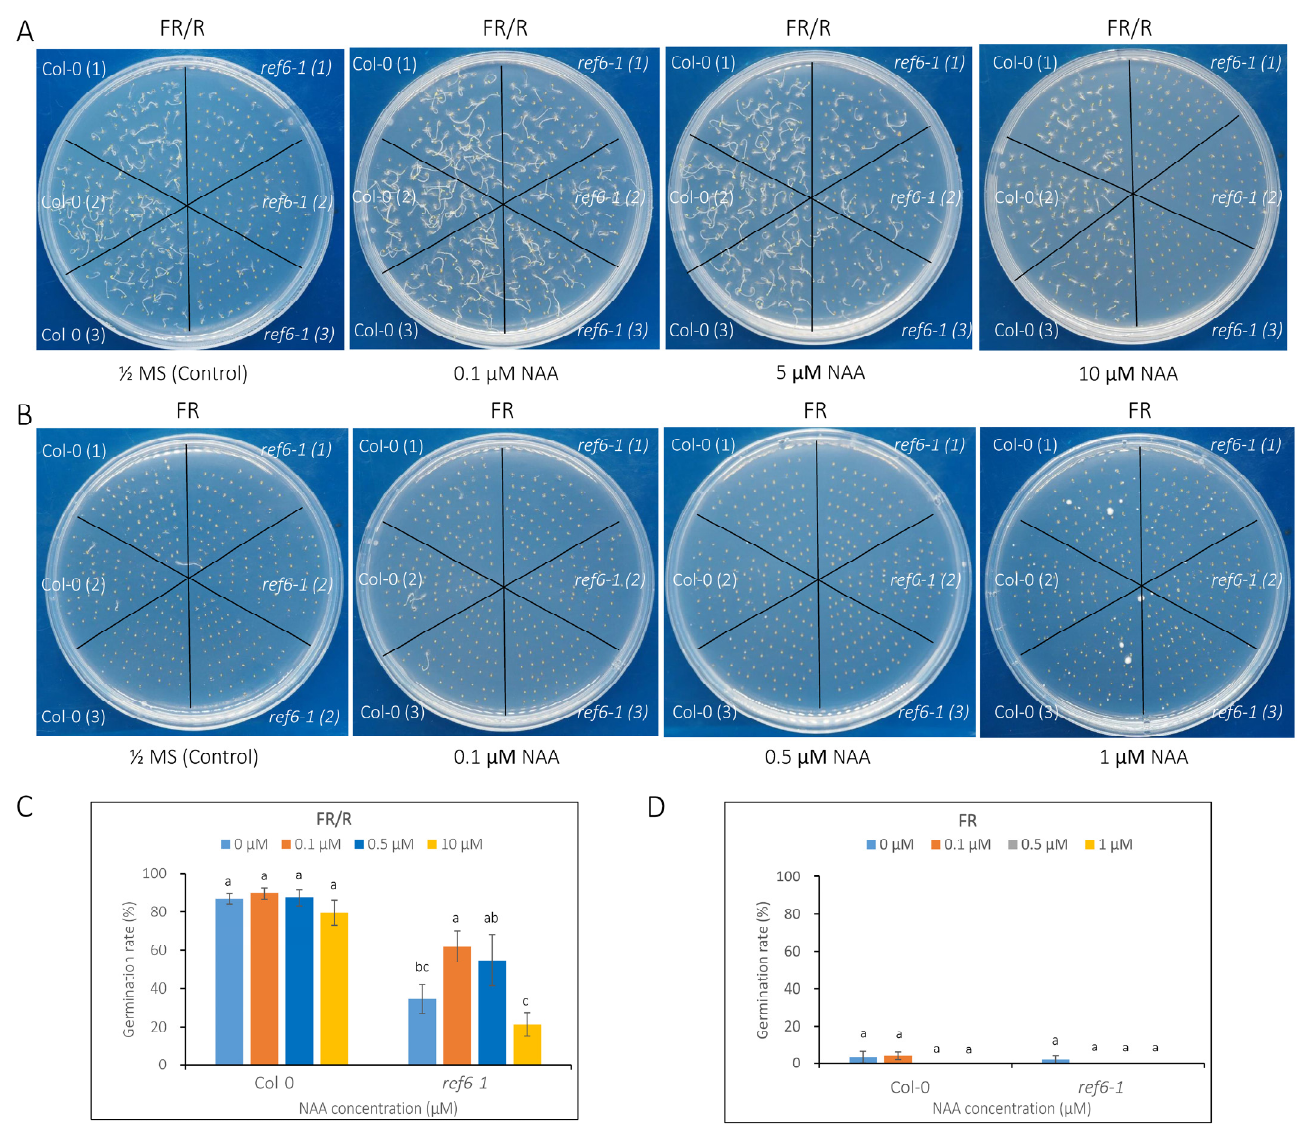
Figure 6. Effect of auxin (NAA) treatments on the seed germination of ref6 mutant under phyB- dependent germination conditions. ( A ) Seed germination patterns of ref6-1 supplemented with 0, 0.1, 5 and 10 μ M NAA under phyB-on (FR/R) conditions. ( B ) Seed germination patterns of ref6-1 supplemented with 0, 0.1, 0.5 and 1 μ M NAA under phyB-off (FR) conditions. ( C ) Calculation of the germination rates of ref6-1 supplemented with NAA under phyB-on conditions. ( D ) Calculation of the germination rates of ref6-1 supplemented with NAA under phyB-off conditions. Different concentrations of NAA were added to the plates before treatment. At least 50 seeds were used for each sample, which was performed in triplicate. Values are shown as means ± SD (n = 3). The data were analyzed by one-way ANOVA. Different letters above bars indicate significant differences at p = 0.05.